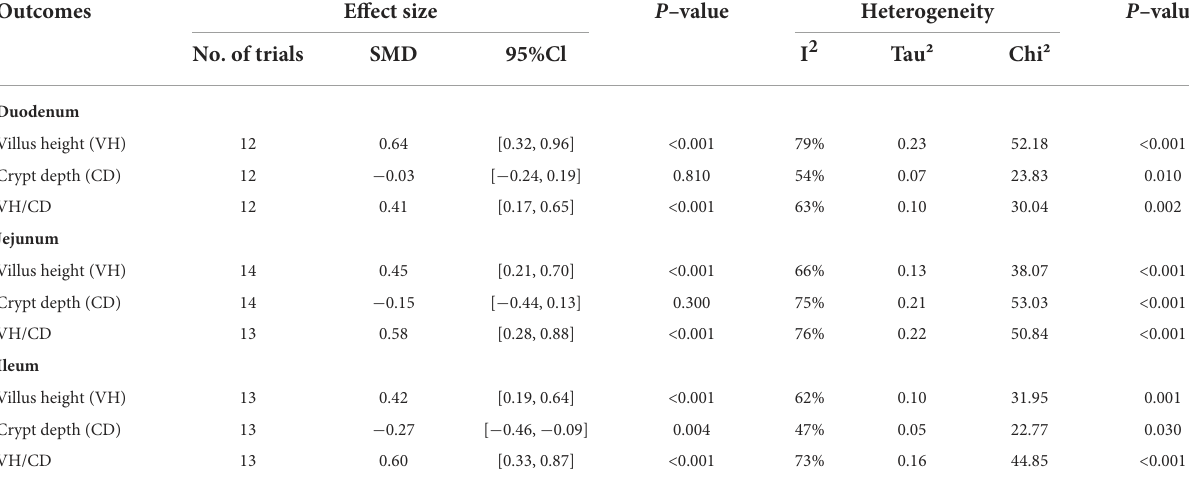
TABLE 5 Effects of Lactobacillus –based probiotics on small intestinal morphology of pigs from included studies.